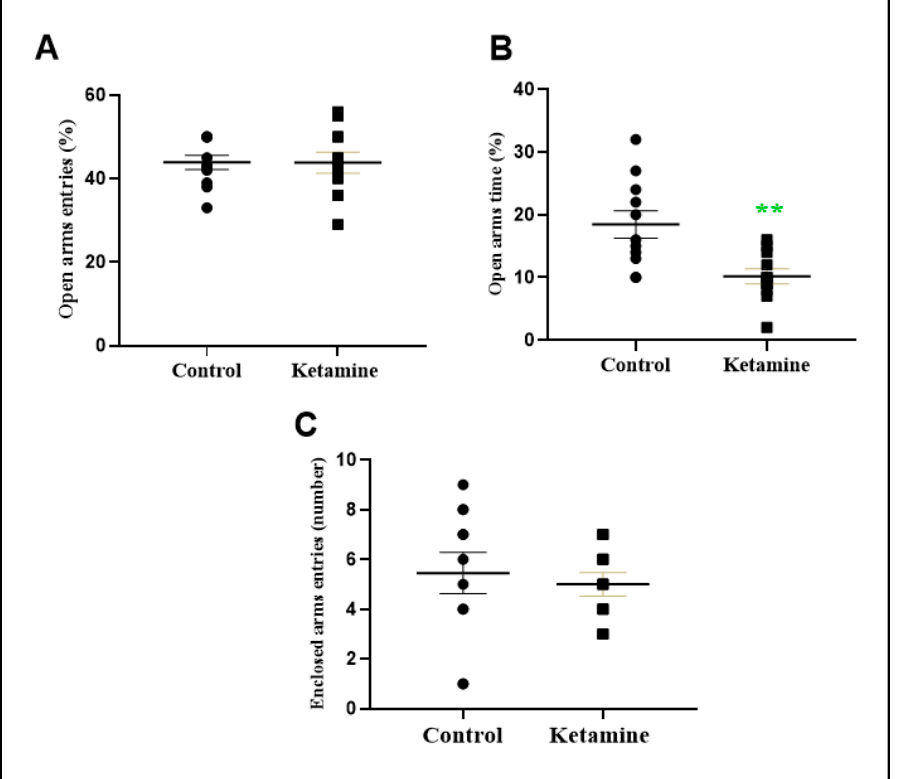
Figure 3. Effects of ketamine recreational regimen (10 mg/kg/day for 3 days, i.p) or saline (control group) in the early withdrawal (24 h) stage on anxiety-like parameters in elevated plus-maze test. Panel ( A ) represents the percentual of open arms entries; Panel ( B ) represents the percentual of open arms time; Panel ( C ) represents the entries of enclosed arms (number) of adolescent female Wistar rats ( n = 10 animals/group). Results were expressed as mean ± S.E.M. ** p < 0.01 compared to control group. Student t-test.